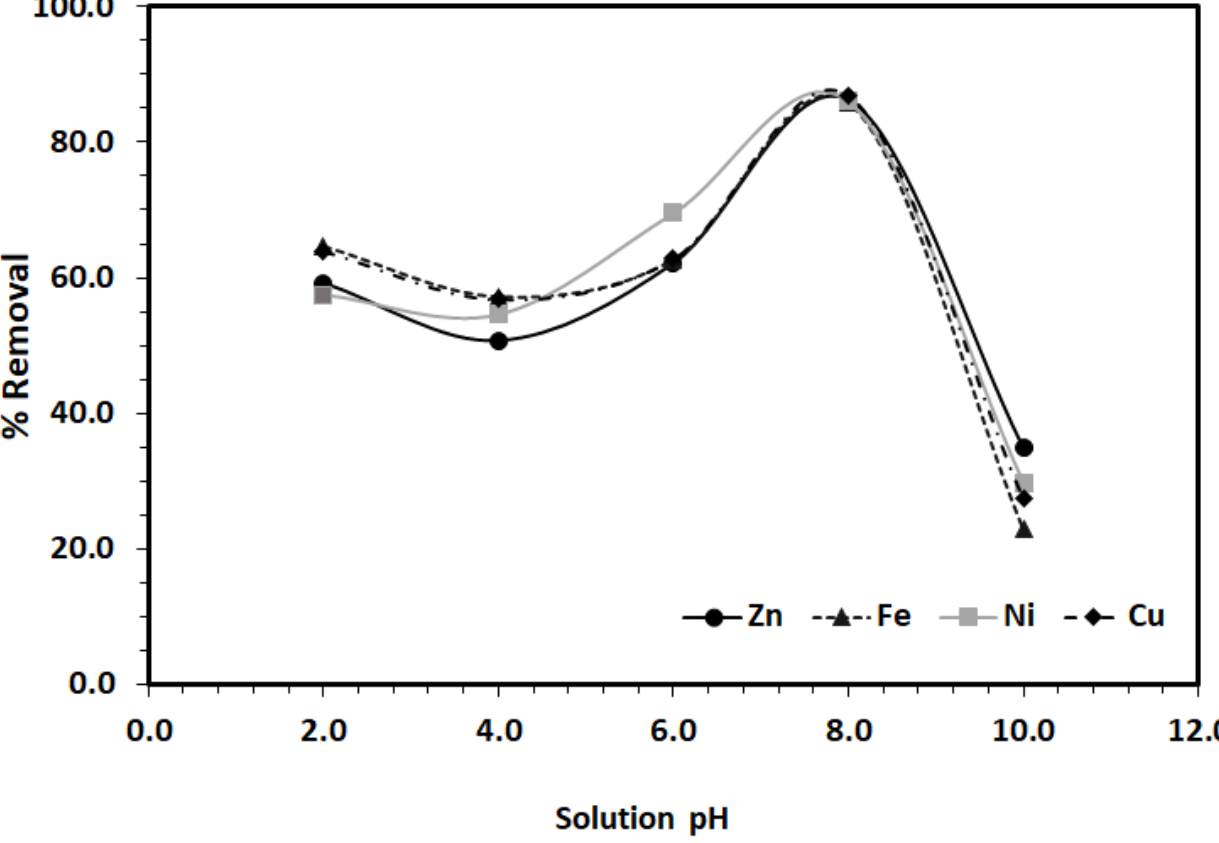
Figure 8. Effect of solution pH on the removal of metal ions (Zn, Fe, Ni, Cu) adsorption from a desalination plant outfall brine discharge by HS nanoclay. (Experimental conditions: 60.0 mL solution, 90 min adsorption time, 150 mg dosage, and 298 K).